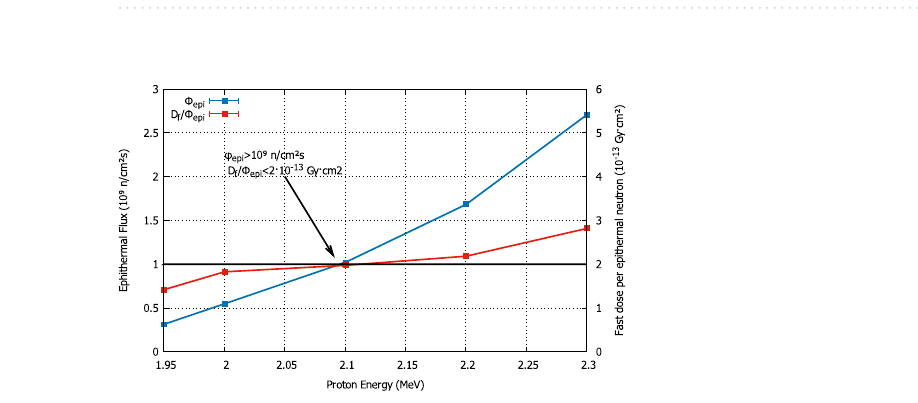
Table 1. Free-air figures of merit for the conformed beam, for different incident proton energies from 1.95 to 2.3 MeV, compared to with the IAEA recommendations. The figures for E p = 2.1 MeV and E p = 2.0 MeV are the only ones that satisfy all criteria at once.